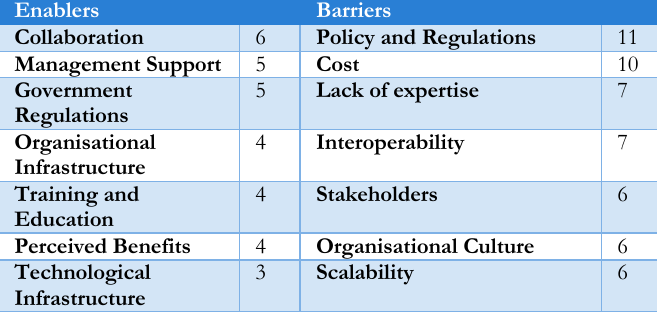
Table 4. Enablers and Barriers to Blockchain